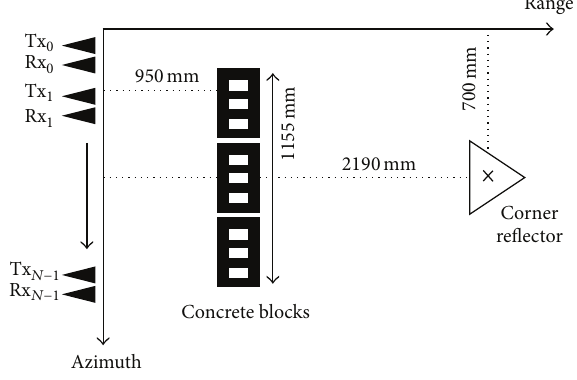
Figure 5: Experimental scene description. The SAR sensor moves in azimuth illuminating the scene with a wide-beam antenna.